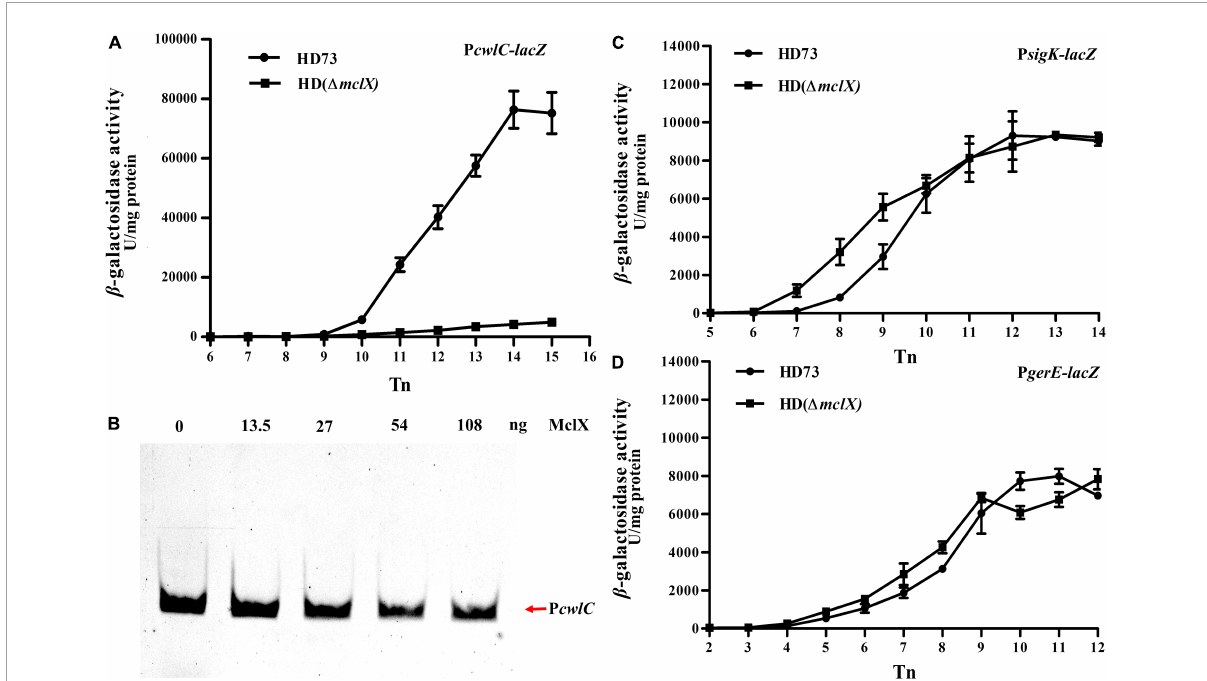
FIGURE4 MclX indirectly affects the transcription of cwlC . (A) cwlC promoter activities in the wild-type strain HD73 and HD ( (cid:49) mclX ) (HD73-P cwlC , circles; HD (cid:49) mclX -P cwlC , squares); (B) the cwlC promoter was unable to interact with the MclX protein based on EMSA. Lane 1, 1 ng FAM-labeled P cwlC probe; lanes 2–5, 1 ng labeled probe with an increasing mass of purified MclX protein; (C) sigK promoter activities in the wild-type strain HD73 and HD ( (cid:49) mclX ) (HD73-P sigK , circles; HD (cid:49) mclX -P sigK , squares); (D) gerE promoter activities in the wild-type strain HD73 and HD ( (cid:49) mclX ) (HD73-P gerE , circles; HD (cid:49) mclX -P gerE , squares). Error bars show standard error of the mean.